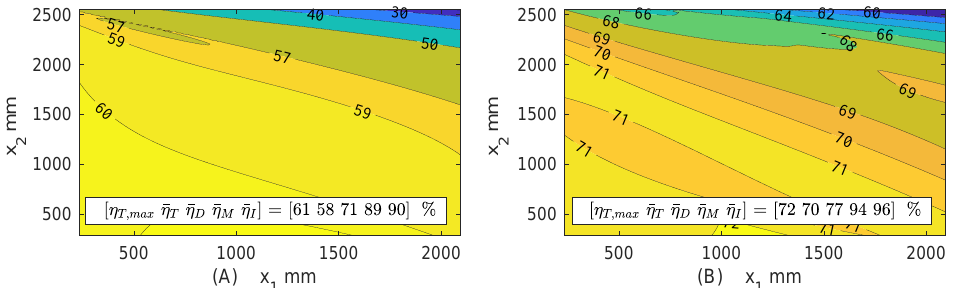
Figure 18. Efficiency for VDN-PP in crane application with interconnection scheme 0 ↔ 1 and 0 ↔ 3. ( A ) Total efficiency under payload extension, − ˙ x 1,max = ˙ x 2,max = 50 mm/s; ( B ) total efficiency under payload retraction, ˙ x 1, max = − ˙ x 2, max = 50 mm/s. ¯ η D , ¯ η M , ¯ η I , ¯ η T , η T,max corresponds to the mean displacement unit, motor, inverter, total efficiencies, and maximum total efficiency.